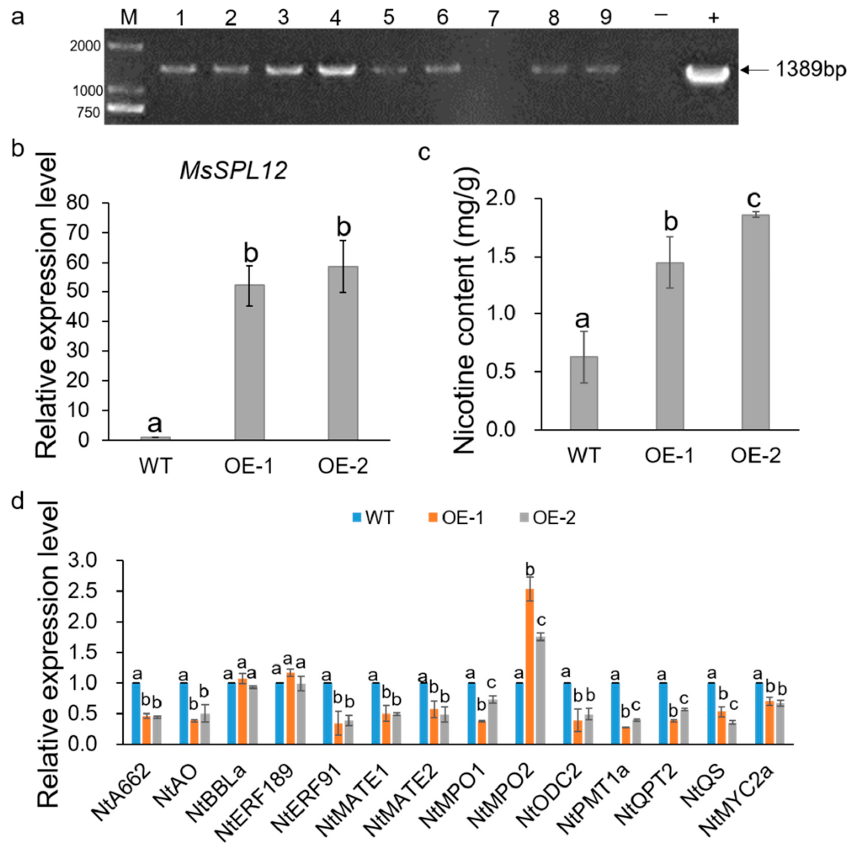
Figure 6. Overexpression of MsSPL12 in tobacco hairy roots led to enhanced nicotine production and altered expression of nicotine biosynthesis and transport related genes: ( a ) PCR targeting MsSPL12 in tobacco hairy roots; ( b ) RT-qPCR test revealing the relative expression level of MsSPL12 in different lines of hairy roots; ( c ) the content of nicotine in hairy roots; ( d ) RT-qPCR test revealing the relative expression of nicotine synthesis and transport related genes in wild-type roots (control) and transgenic hairy roots overexpressing MsSPL12. The data are presented as the mean ± standard error (SE) ( n = 3) and were statistically analyzed using one-way ANOVA. The comparison of treatments was conducted using Duncan’s multiple range test ( p < 0.05). Different letters indicate a statistically significant difference ( p <